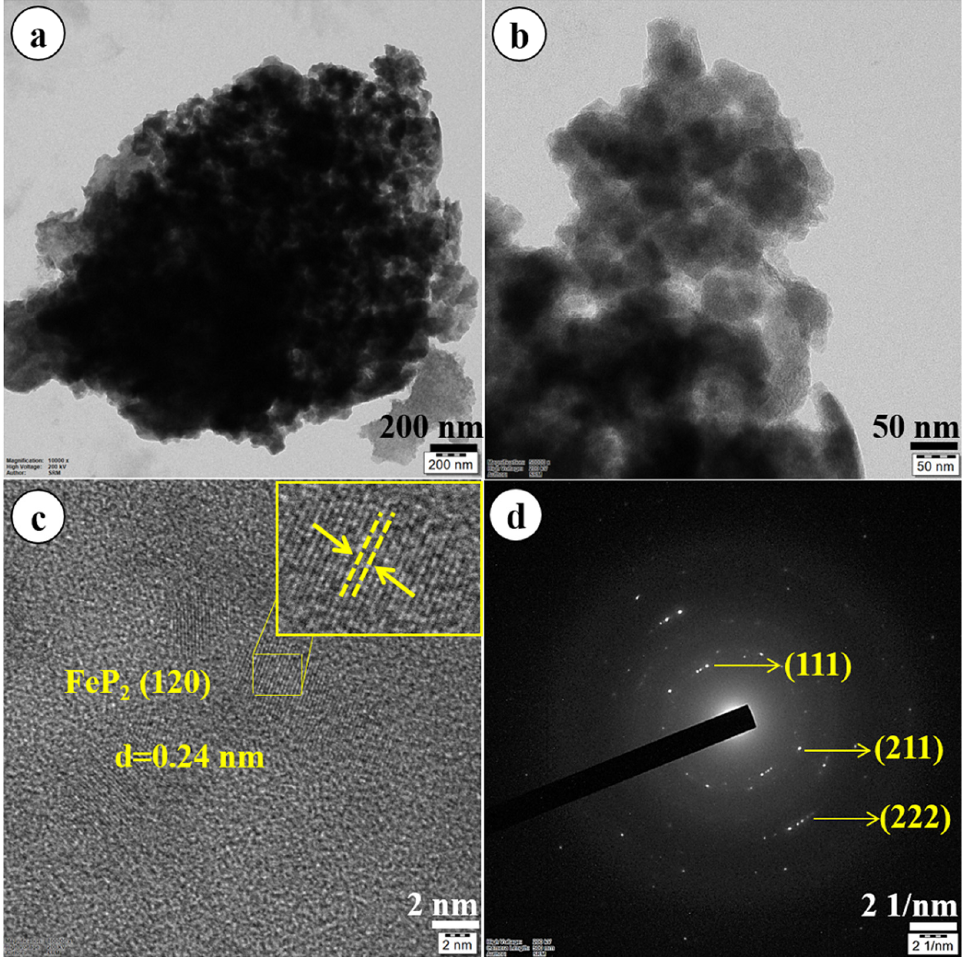
Figure 4. TEM image ( a , b ), HR ‐ TEM ( c ), and SAED ( d ) pattern of the PS ‐ 3D ‐ FeP@NiO nanostructures.